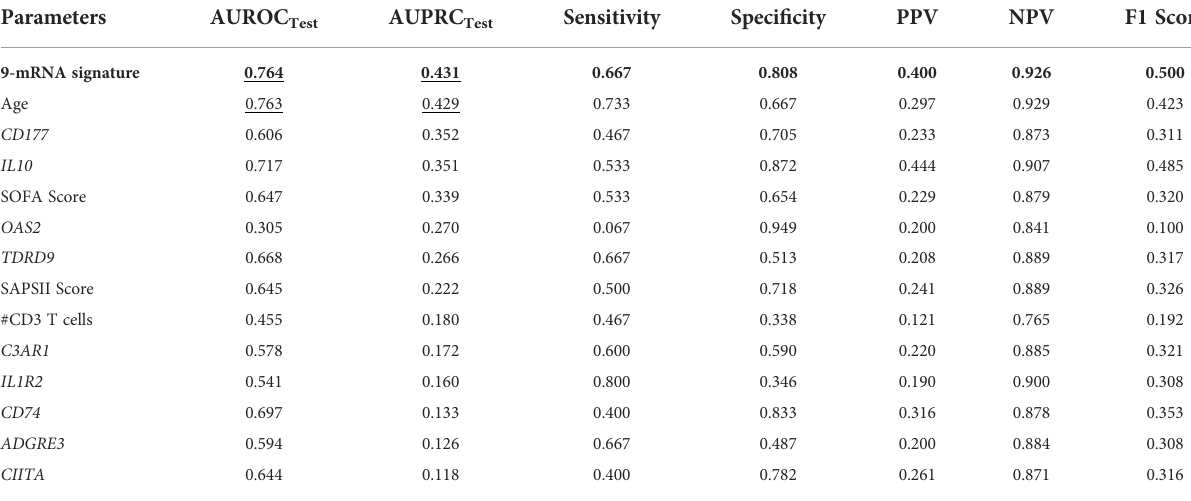
TABLE 5 Indicators of 28-day survival prediction performance of individual transcripts and the 9-mRNA panel along with age, CD3 T cells count, SOFA and SAPS II scores at admission.